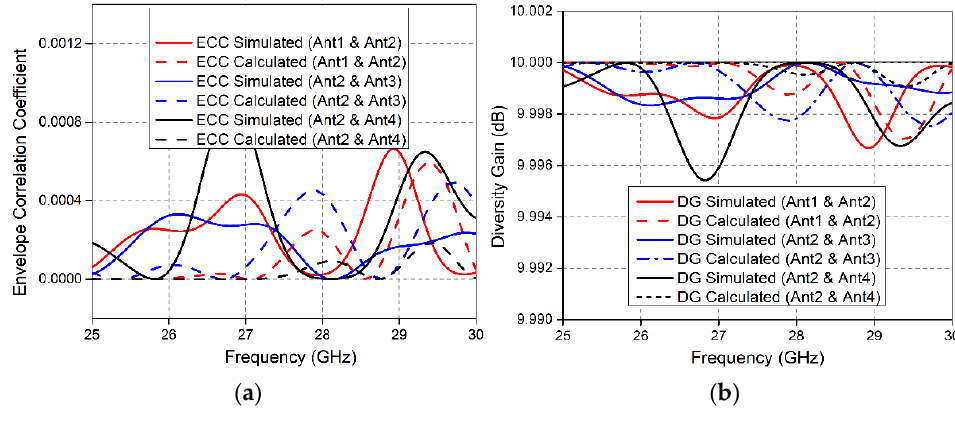
Figure 14. ( a ) ECC and ( b ) DG of the proposed MIMO